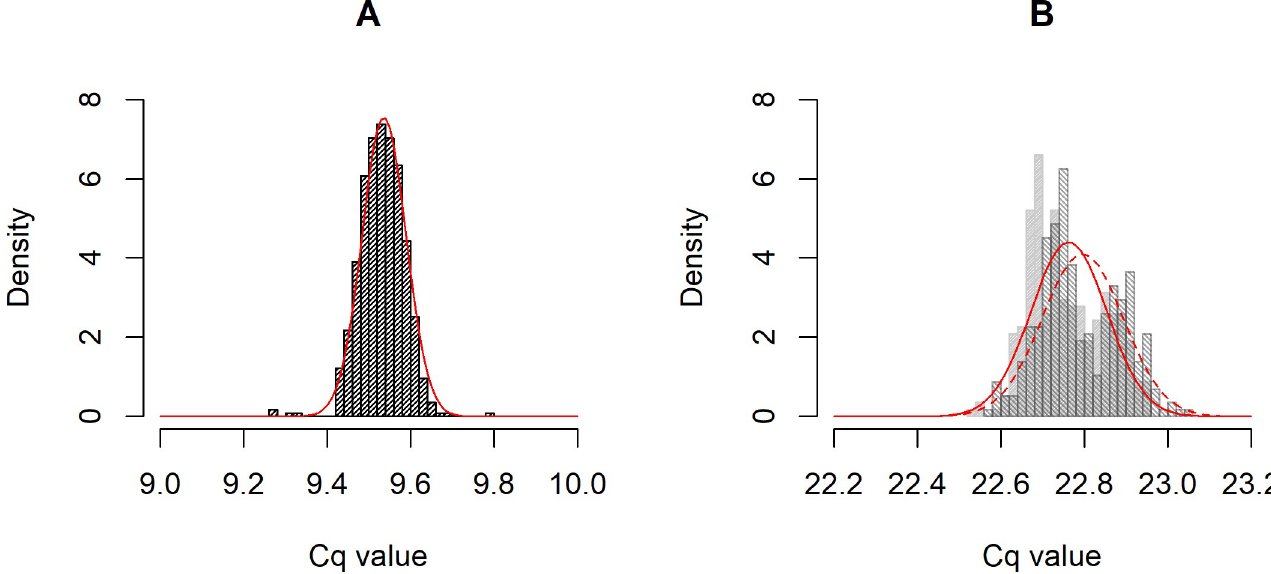
Fig 1. Observed distributions of Cq values for telomere (A) and single-copy gene (B) in dataset 1. For the single-copy gene where the mean Cq varied significantly by plate, each plate is shown in a different shading. Lines show a superimposed normal density (separately by plate for single-copy gene).